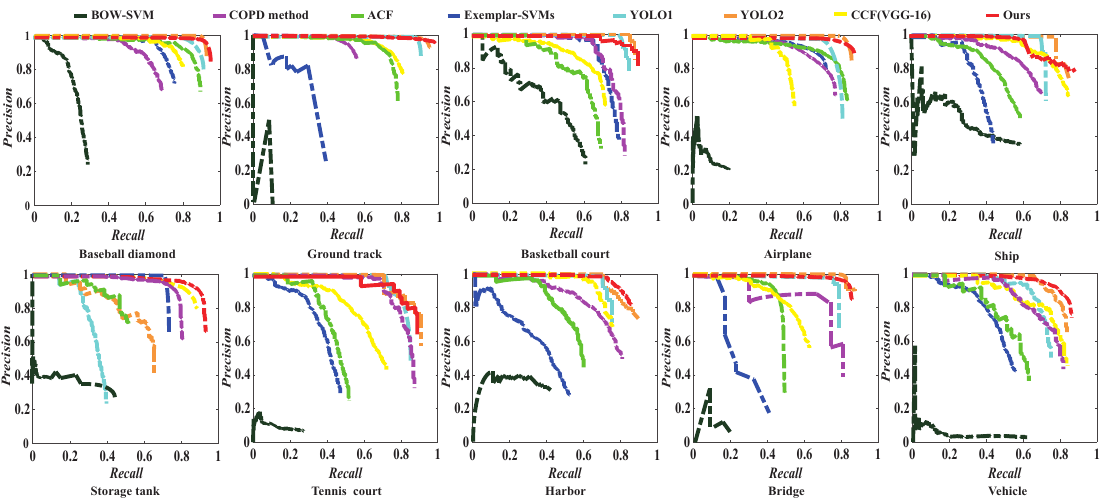
Figure 6. Precision–recall curve (PRC) of the proposed method and seven competitive methods using the NWPU VHR-10 dataset for 10 object